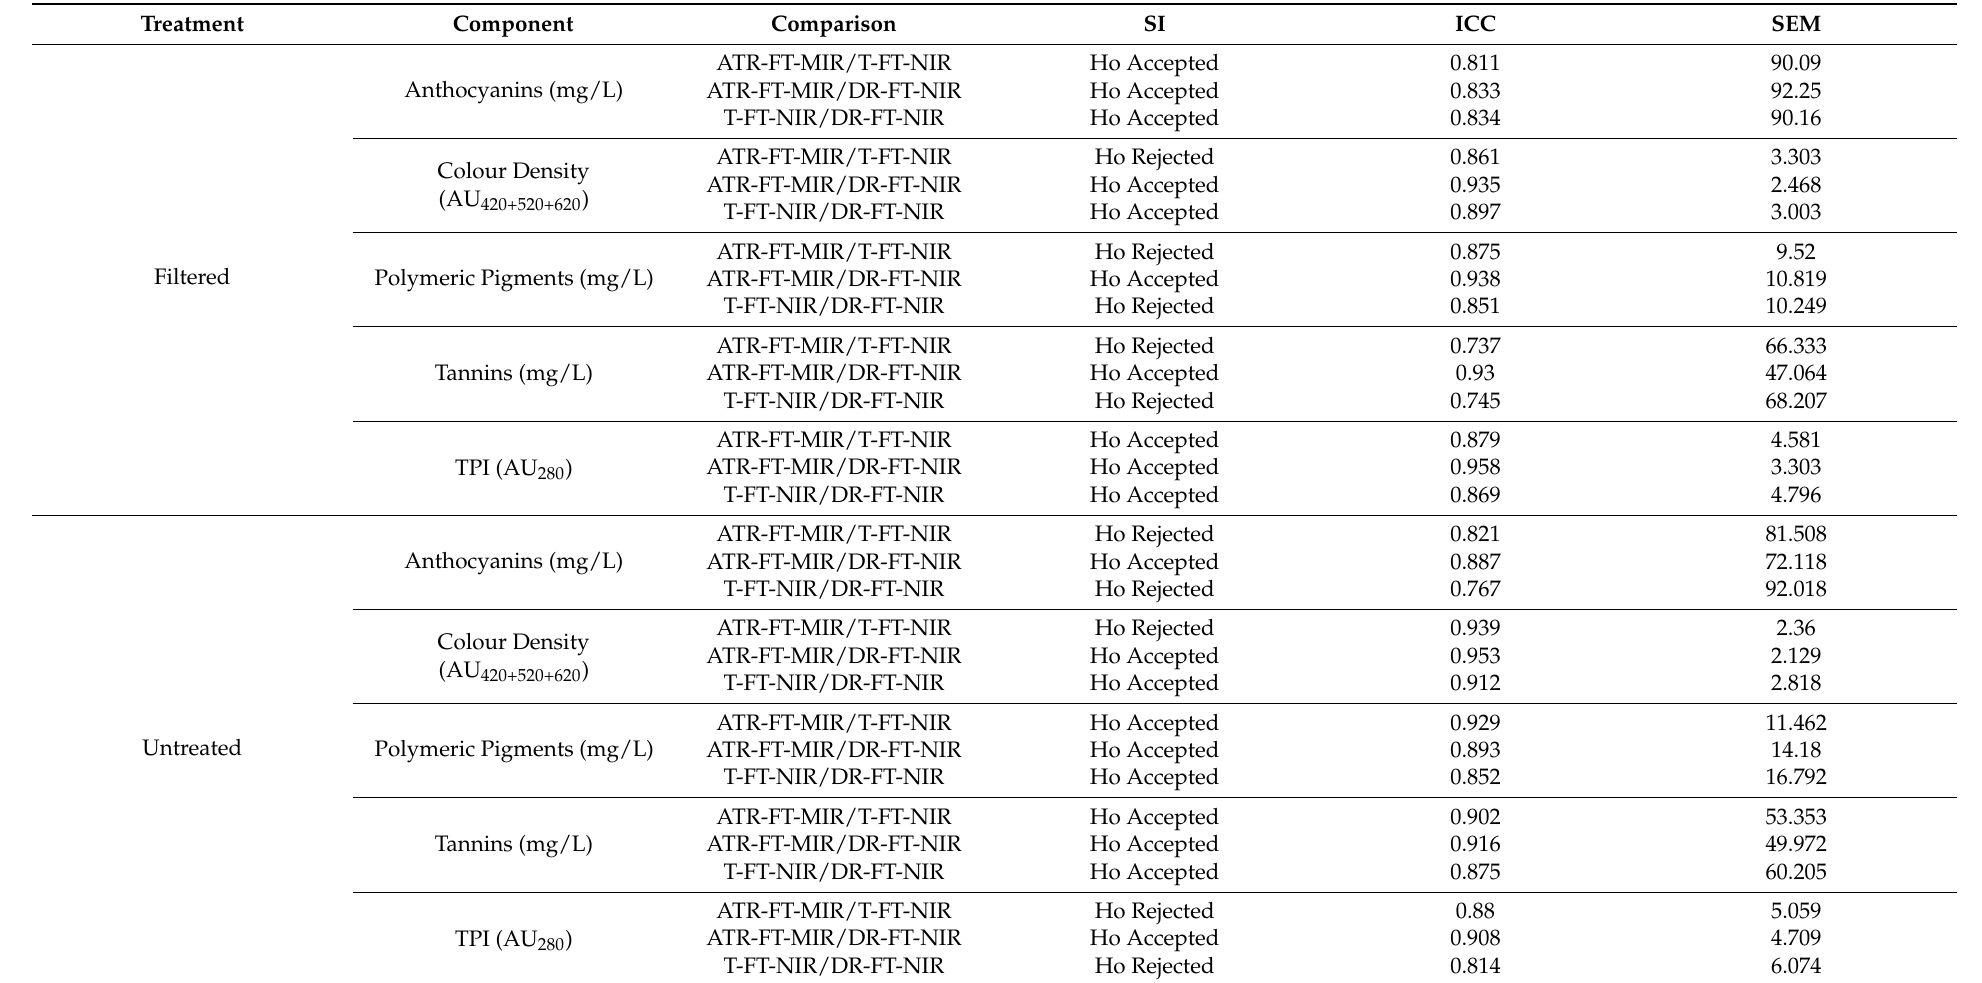
Table 5. Summary Statistics for Instrument Comparison for the phenolic parameters